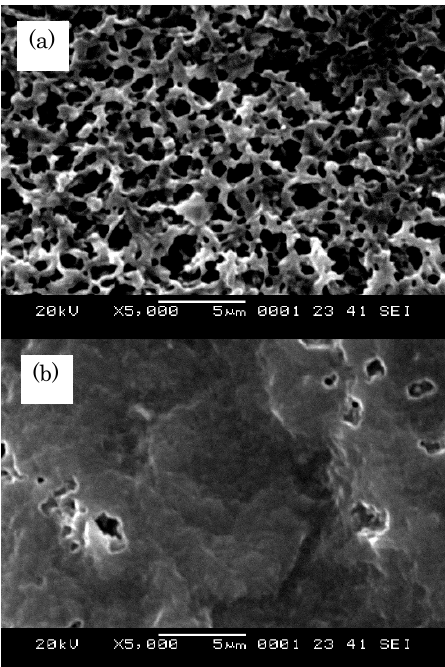
Figure 3. SEM micrographs of surface of AAc-grafted PVDF: ( a ) AAc-grafted PVDF (GD 25%) and ( b ) AAc-grafted PVDF (after heat compression treatment), respectively.